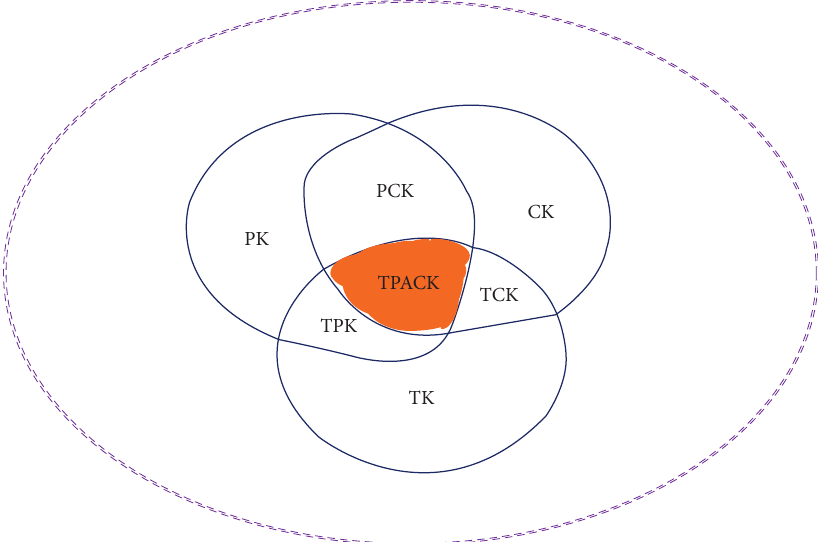
Figure 2: TPACK framework and its constituent